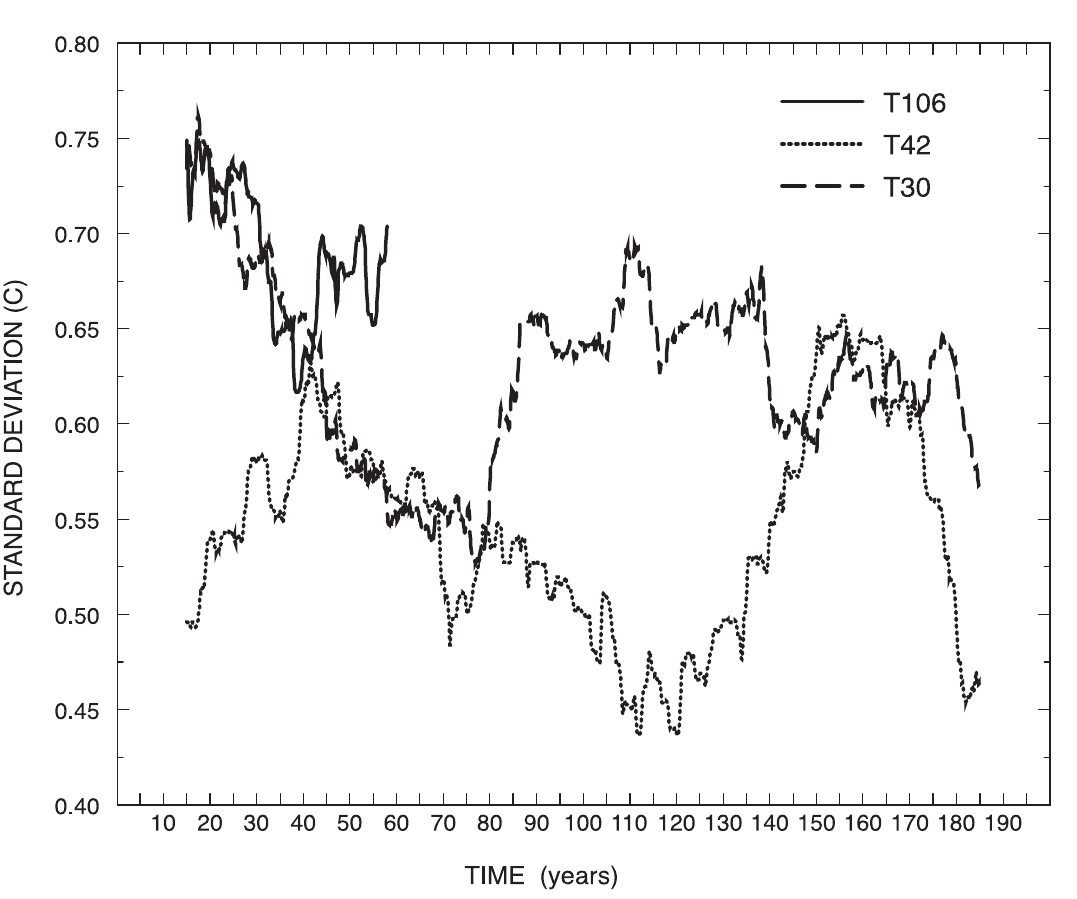
Fig. 13. Standard deviation over moving 15-year windows for the NIÑO-3 SSTA. Solid line curve: T106 ex- periment; dotted line curve: T42 experiment; dashed line curve: T30 experiment.